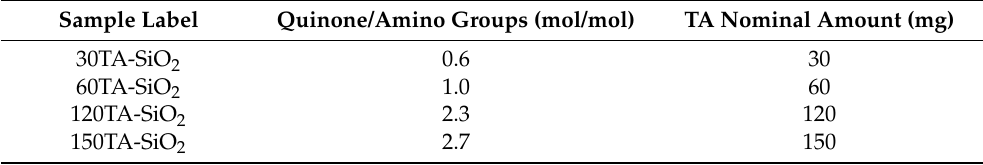
Table 1. Quinone/amino groups molar ratio and TA nominal amount used during synthesis. Sample